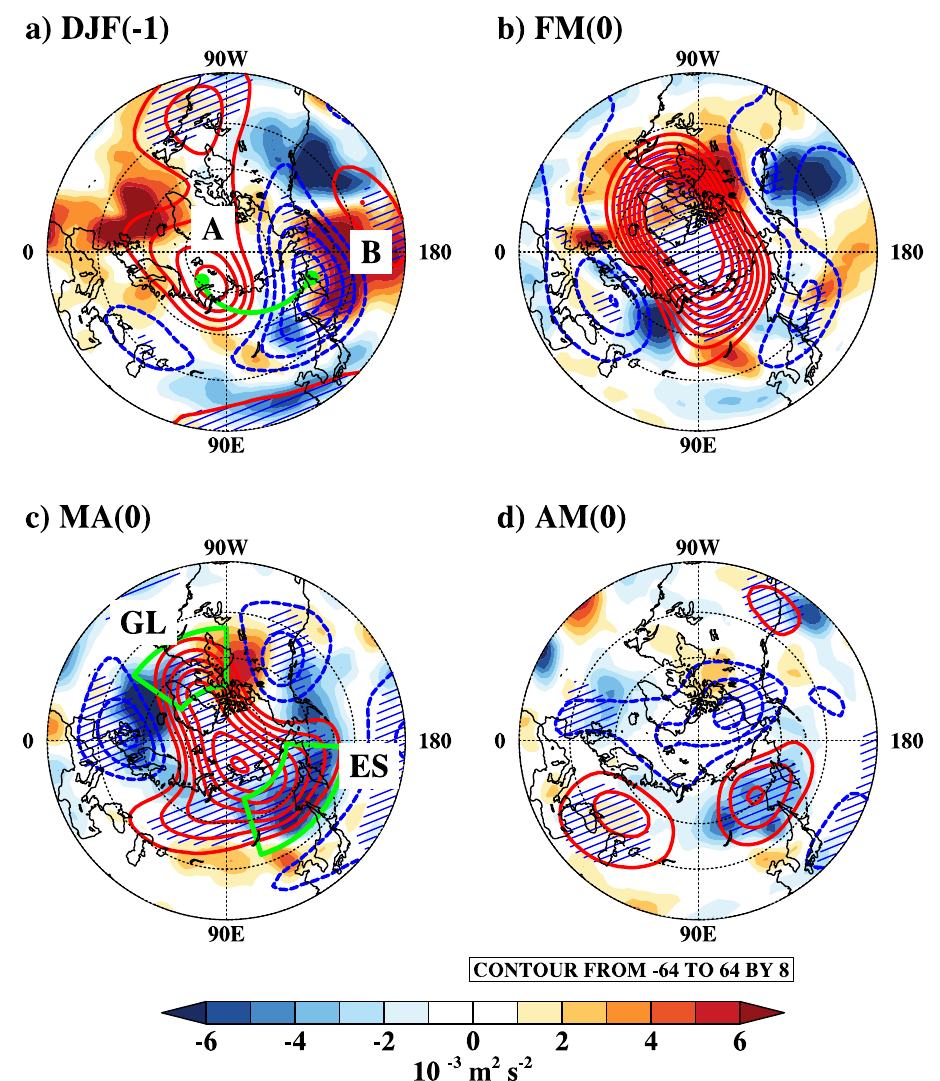
Fig. 2 Evolution of BK sea ice-related atmospheric circulations from winter to spring. Vertical component of 200-hPa WAF (10 − 3 m 2 s − 2 , shading) and 100-hPa geopotential height (m, contour) anomalies in a DJF( − 1), b February – March (FM(0)), c March-April (MA(0)), and d April – May (AM(0)) regressed onto the negative winter BK sea ice index. The green line in ( a ) is from grid A (75°N, 50°E) to grid B (58°N, 163°E). The green boxes in ( c ) are the regions of Greenland (GL, 50° − 70°N, 35° − 90°W) and eastern Siberia (ES, 48° − 68°N, 107° − 177°E). Contour interval is 8 m. Blue and red contours indicate the negative and positive geopotential height anomalies. Hatched areas denote geopotential height anomalies signi fi cant at the 90% con fi dence